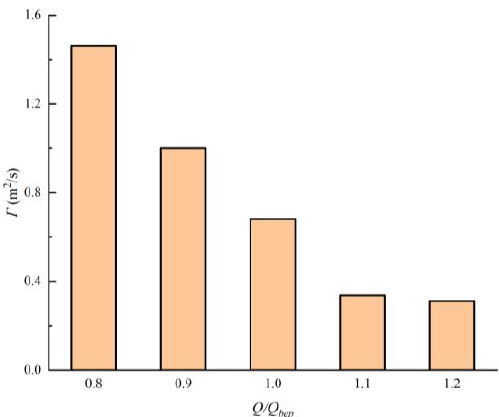
Figure 13. The velocity circulation of guide vane outlet.